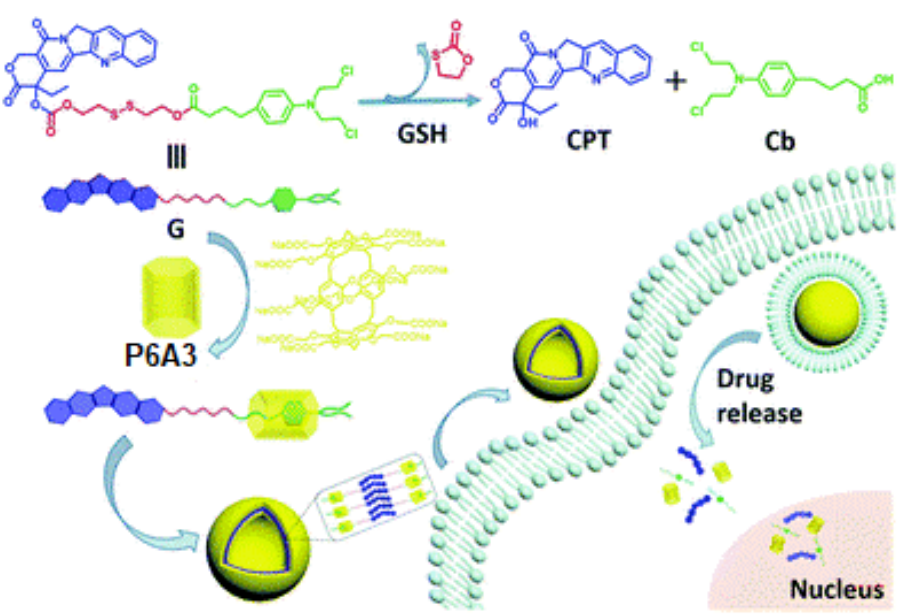
Figure 7. Schematic design of a P6A3 -supported dual prodrug guest ( G ) system. Reproduced with the permission of reference [85]. Copyright © Royal Society of Chemistry 2018.